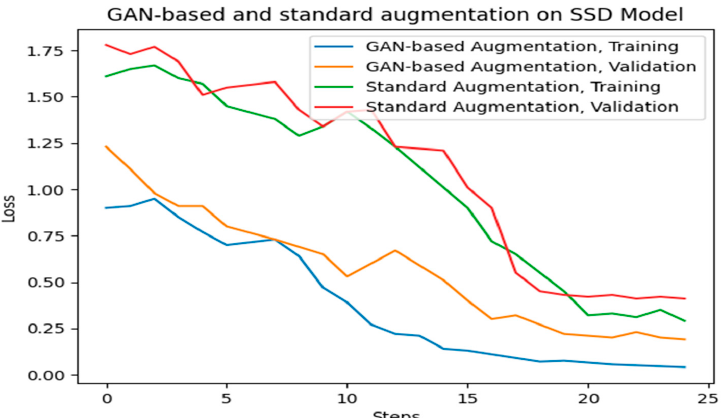
Figure 14. Training and validation losses between the proposed augmentation pipeline and the standard augmentation method on SSD.